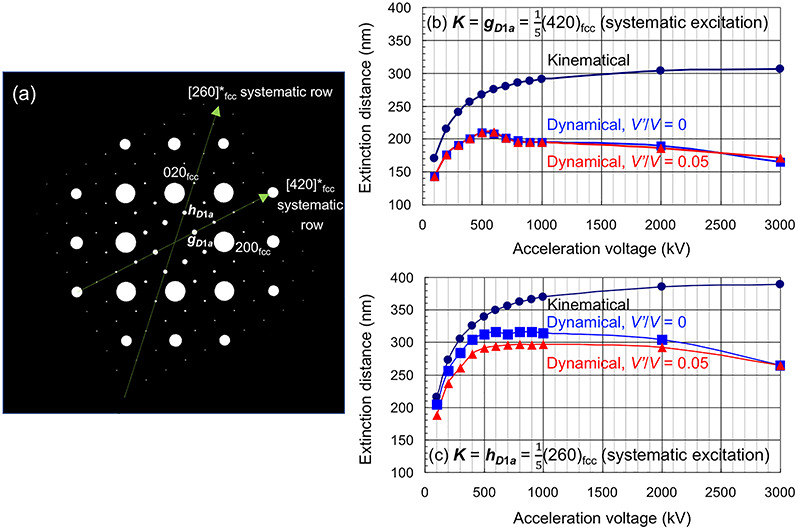
Calculated dynamical electron diffraction intensities of the fundamental lattice reflection, hkl = 200, and the superlattice reflection, hkl = \documentclass[12pt]{minimal}
\usepackage{amsmath}
\usepackage{wasysym}
\usepackage{amsfonts}
\usepackage{amssymb}
\usepackage{amsbsy}
\usepackage{upgreek}
\usepackage{mathrsfs}
\setlength{\oddsidemargin}{-69pt}
\begin{document}
}{}$\frac{1}{5}$\end{document}(420), as functions of the Ni4Mo crystal thickness. The calculations were performed using the software, JEMS [102], under the following conditions: acceleration voltage of 200 kV; the exact Bragg condition under the systematic excitation for each reflection; the ratio of inelastic scattering (absorption) and elastic scattering potential values for a diffracted wave g, \documentclass[12pt]{minimal}
\usepackage{amsmath}
\usepackage{wasysym}
\usepackage{amsfonts}
\usepackage{amssymb}
\usepackage{amsbsy}
\usepackage{upgreek}
\usepackage{mathrsfs}
\setlength{\oddsidemargin}{-69pt}
\begin{document}
}{}$\frac{V_{\boldsymbol{g}}^{\prime }}{V_{\boldsymbol{g}}}$\end{document} = 0.05 or 0.